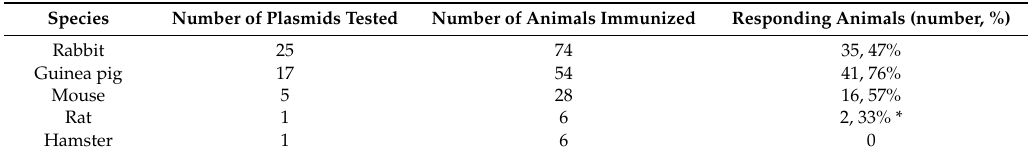
Table 2. Polyclonal antibodies